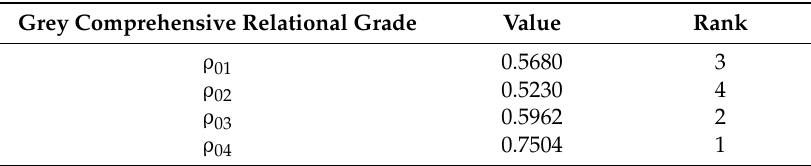
Table 3. The results of GRGA analysis on pile-up ratio.